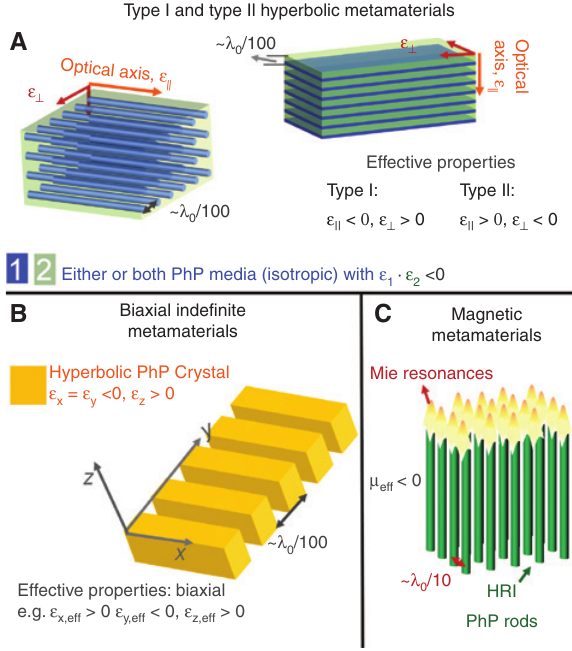
Figure 22: PhP metamaterials: Representative characteristic structures with indicative building-block sizes with respect to the free-space wavelength, λ . 0 (A) Type I and Type II PhP hyperbolic metamaterials (see [80, 240–242]). (B) Biaxial indefinite PhP metamaterial from natural PhP hyperbolic crystals, e.g. hBN (see [243]). (C) Magnetic PhP metamaterial (see [181, 244,